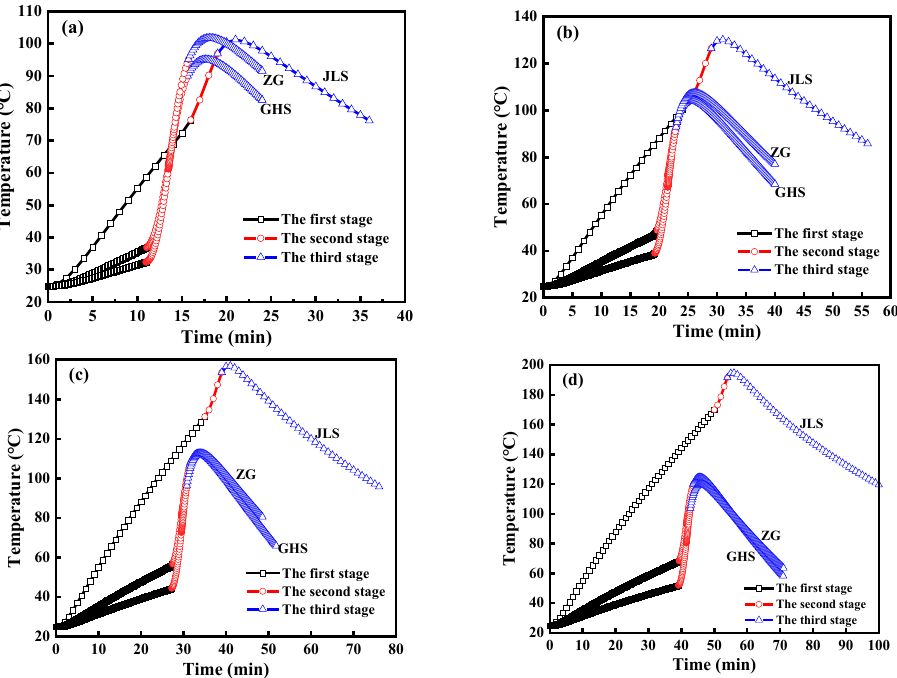
Figure 22. Prediction of temperature of measuring point on core tube wall during coring for different coal mines: ( a ) is the core depth of 30 m; ( b ) is the core depth of 50 m; ( c ) is the core depth of 70 m; and ( d ) is the core depth of 100 m.